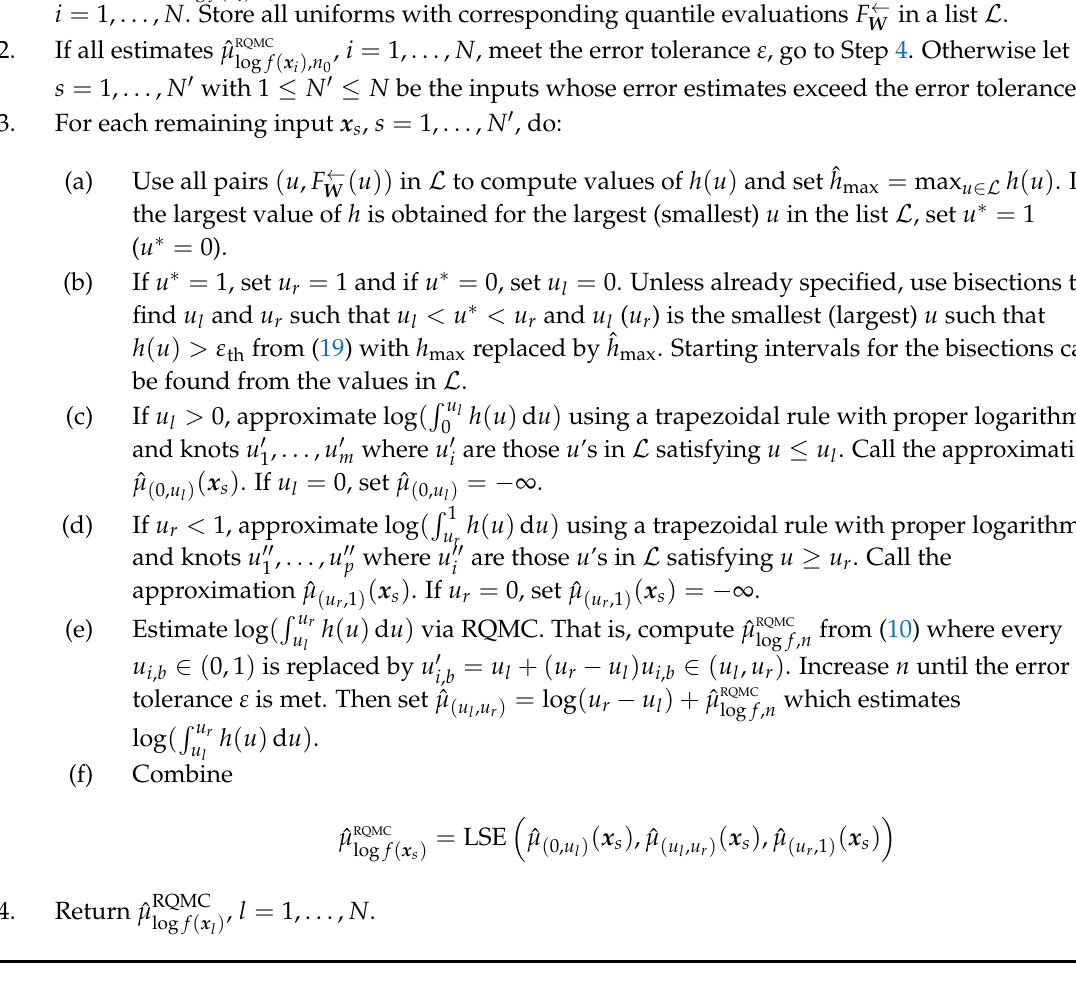
Algorithm 1: Adaptive RQMC Algorithm to Estimate log ( f ( x 1 )) , . . . , log ( f ( x n ))